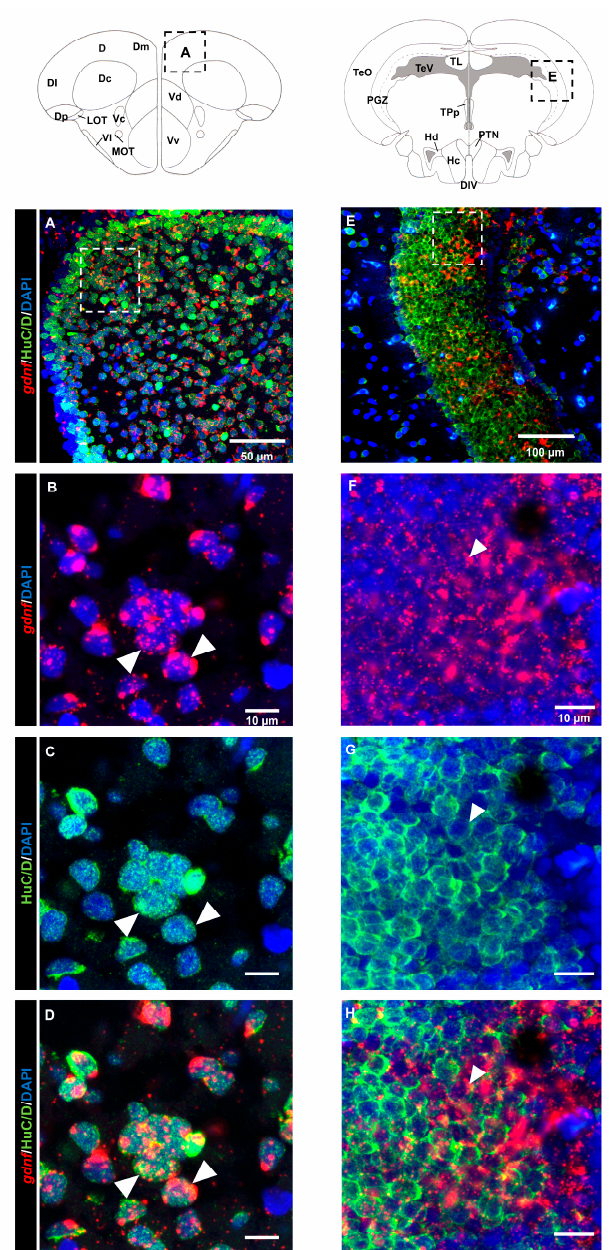
6 Figure 5. Coronal sections of adult brain revealing early-di ff erentiated neuronal marker (HuC / D) immunoreactivity co-localized with gdnf mRNA. gdnf mRNA is co-expressed with HuC / D as indicated with white arrowheads in ( A – D ) dorsal telencephalic area, and ( E – H ) periventricular gray zone (PGZ) of the optic tectum. Black dashes in the graphical illustrations outline the regions of interest. The white dashes outline the enlarged regions that were constructed from selected z-stacks. Abbreviations: D: Dorsal telencephalic area; Dc: Central zone of dorsal telencephalic area; DI: later zone of dorsal telencephalic area; Dm: Medial zone of dorsal telencephalic area; Dp: Posterior zone of